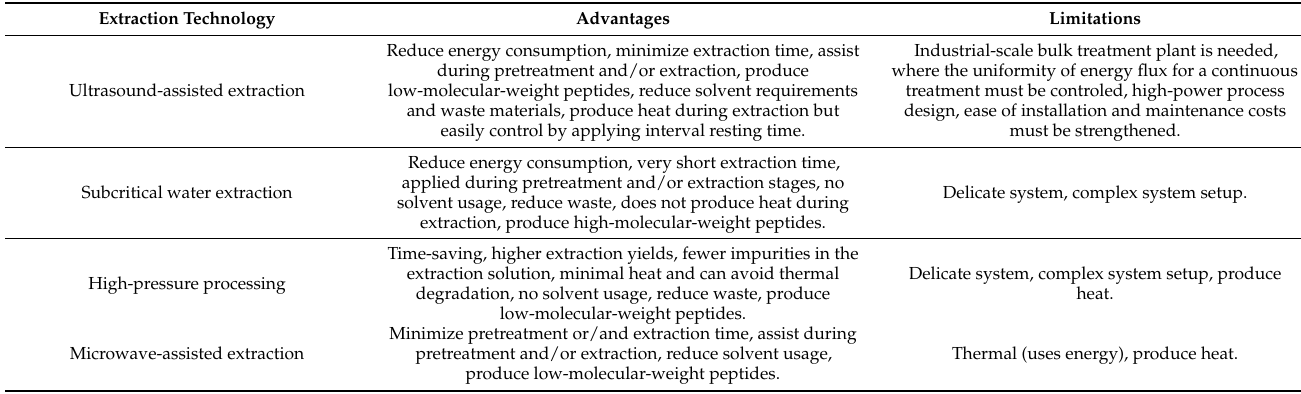
Table 3. Summary of advantages and disadvantages of green extraction